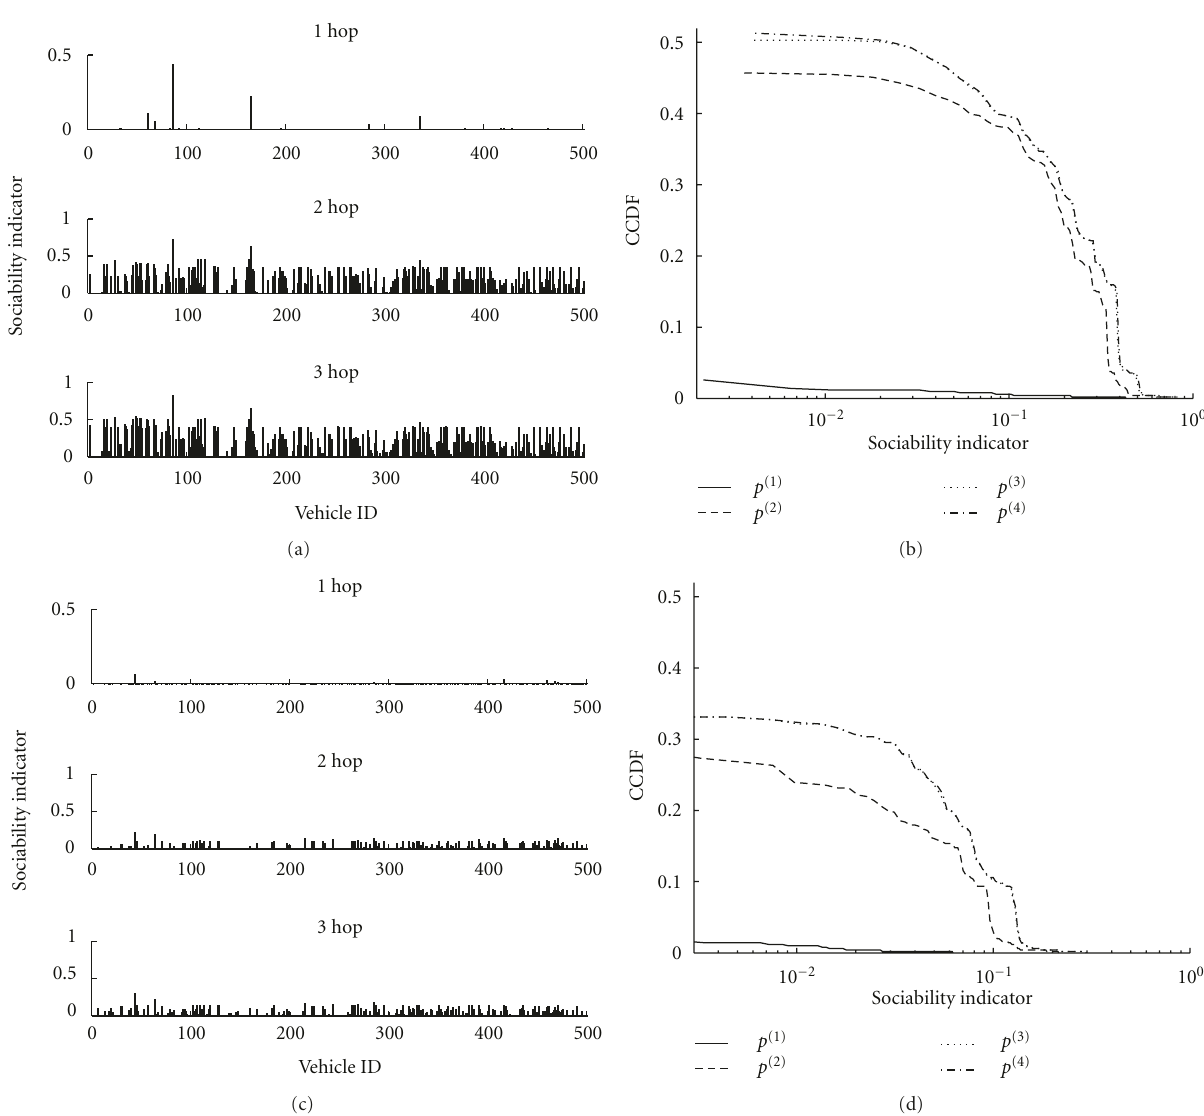
Figure 4: Bar plots ((a), (c)) and Complementary Cumulative Distribution Function (CCDF) plots ((b), (d)) of sociability indicators computed over two di ff erent time windows of duration T = 100 second